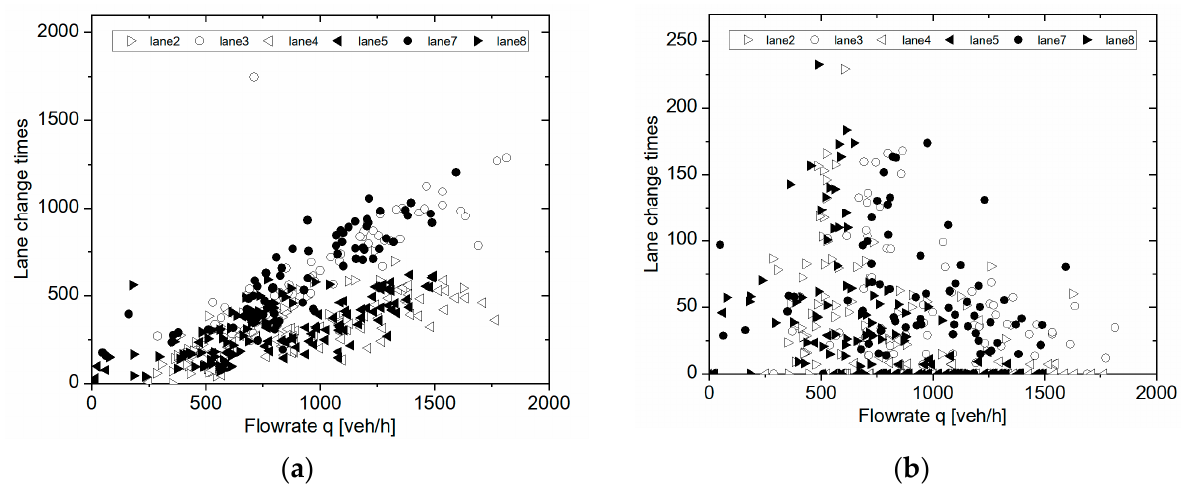
Figure 7. ( a ) Car lane change times versus flow rate; ( b ) Truck lane change times versus flow rate.